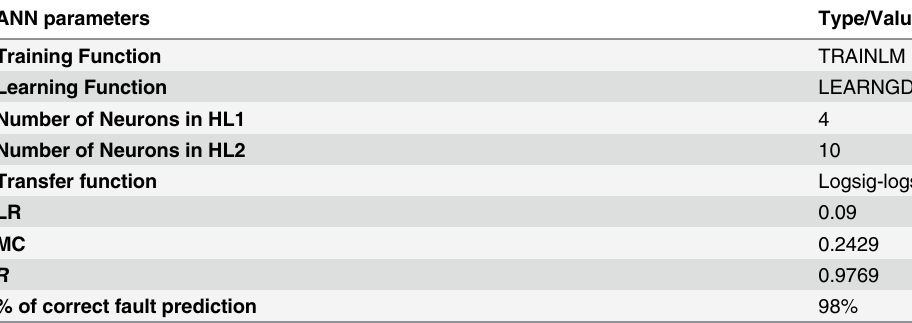
Table 7. The properties of selected ANN combined with